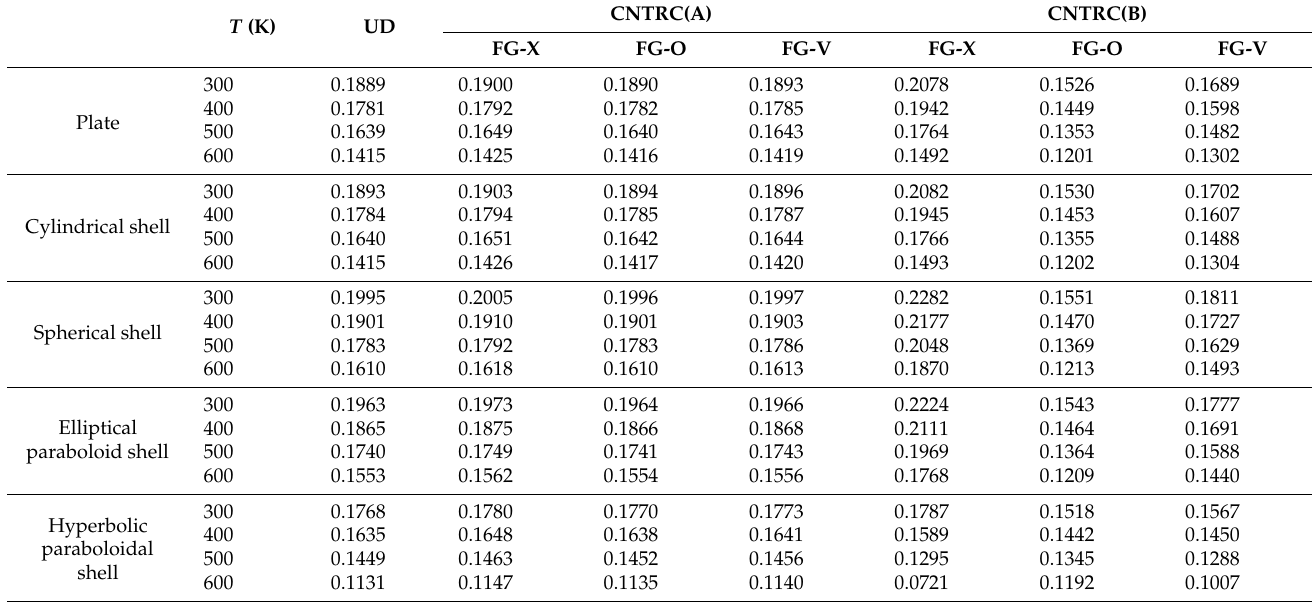
Table 5. Effect of temperature on the dimensionless frequency of CNTRC shells (SSSS, p = 1, N = 10, b / a = 1, a / h = 10, V cnt = 0.17